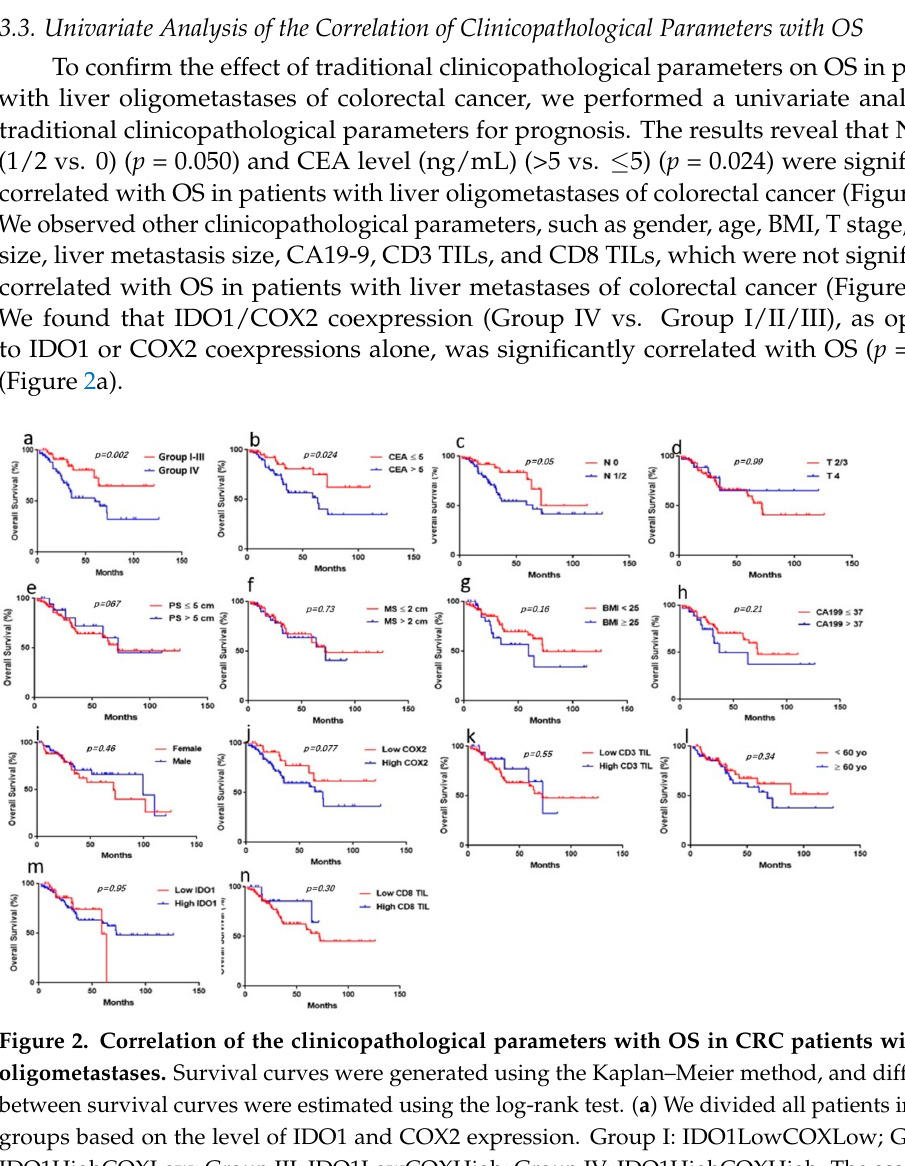
Figure 2. Correlation of the clinicopathological parameters with OS in CRC patients with liver oligometastases. Survival curves were generated using the Kaplan–Meier method, and differences between survival curves were estimated using the log-rank test. ( a ) We divided all patients into four groups based on the level of IDO1 and COX2 expression. Group I: IDO1LowCOXLow; Group II: IDO1HighCOXLow; Group III: IDO1LowCOXHigh; Group IV: IDO1HighCOXHigh. The association of the four groups (IV vs. I-III) with OS was significant ( p = 0.002); ( b , c ) correlation between CEA and N stage and OS in patients; b: CEA ( p = 0.024); c: N stage ( p = 0.05). ( d – n ): Correlation between other clinicopathological parameters and OS in patients. ( p >